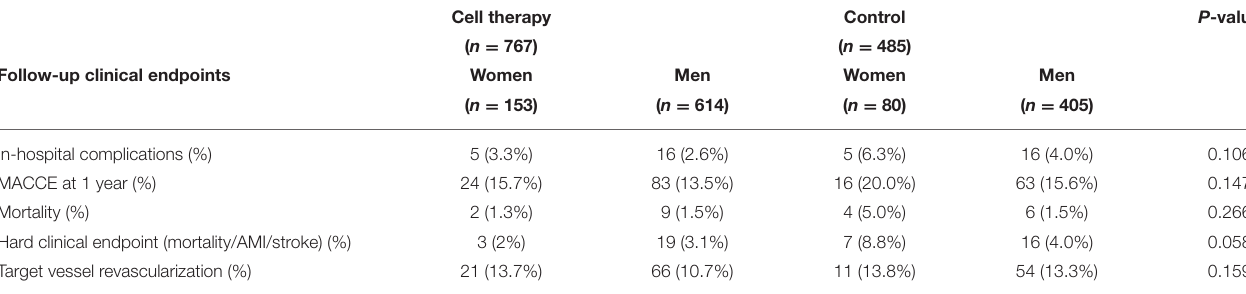
TABLE 3 | Outcome characteristics in cell-treated and control groups stratified by sex. Cell therapy Control P -value